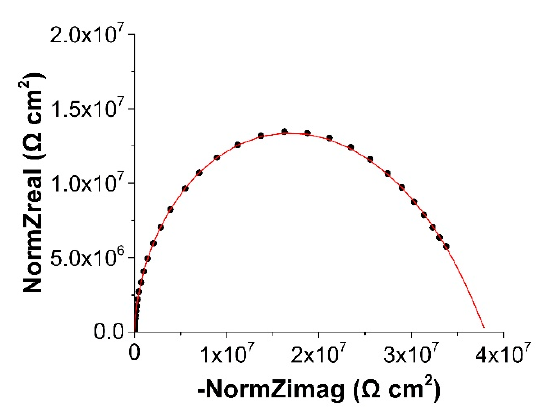
Figure 6. Nyquist plot of S4 fitted using the equivalent circuit (Figure 2) after immersing for 1 h in 0.1 wt.% NaCl.